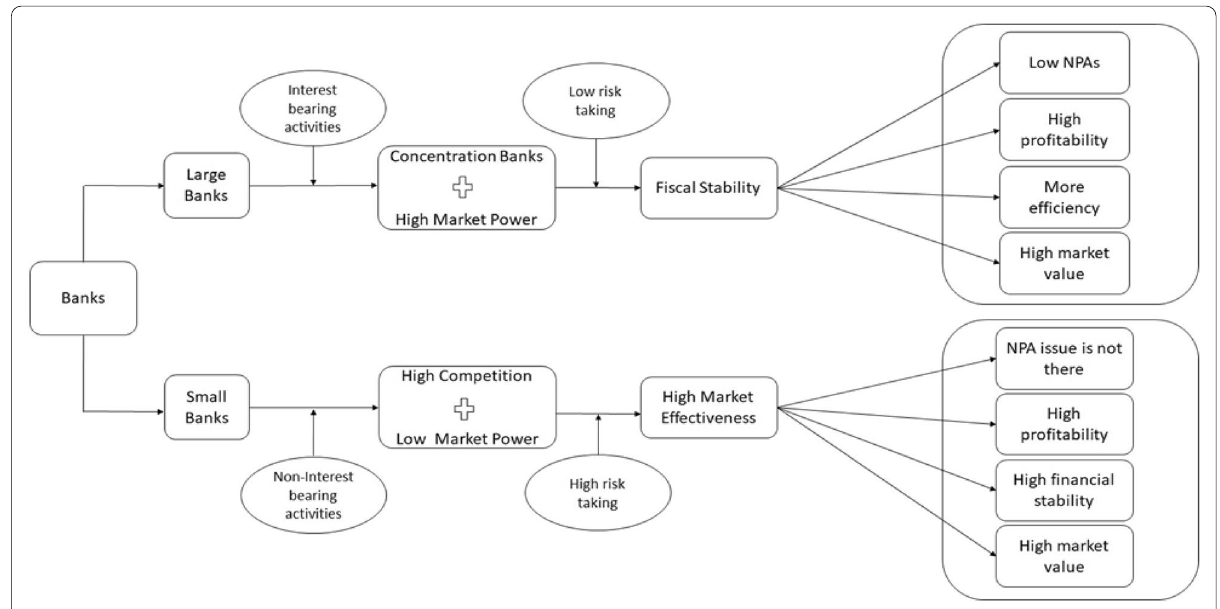
Fig. 7 Conceptual Framework. Note Fig. 7 describes the conceptual framework of the